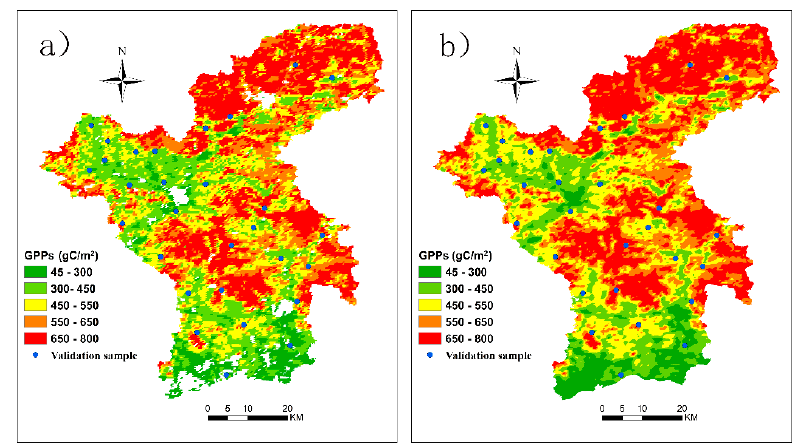
Figure 3. The spatial distribution maps of the cumulative GPP from the 233rd to 289th days in the study area in 2013: ( a ) 500 m original standard MODIS-GPPs and ( b ) 30 m MODIS-GPPs interpolated by the Empirical Bayes Kriging (EBK) method.